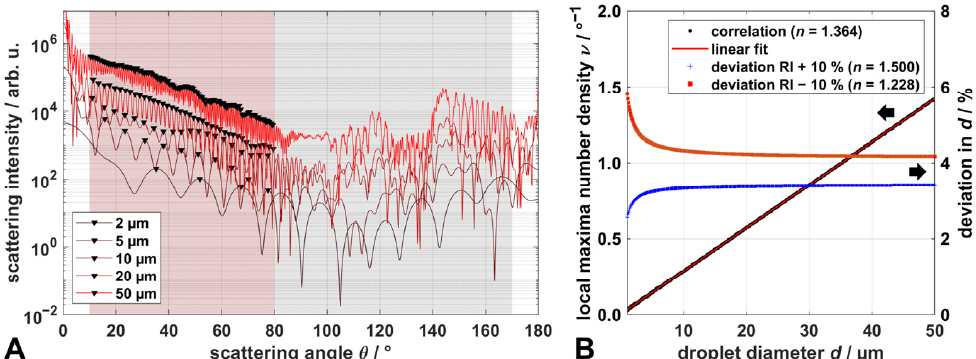
Figure 1. ( A ): Scattering data of spherical EtOH droplets calculated with Mie theory for diameters d between 2 µm and 50 µm for vertically polarized light with a wavelength of 532 nm (the periodically occurring local maxima are marked with ▼ for each data set, the region accessible with WALS is shaded, the evaluation region of WALS is additionally highlighted in red); ( B ): linear correlation curve between droplet diameter d and local maxima number density ν (see text) derived from calculated scattering data and deviation, i.e., over- or underestimation, respectively, of the droplet size for a refractive index variation of ± 10% based on the refractive index of